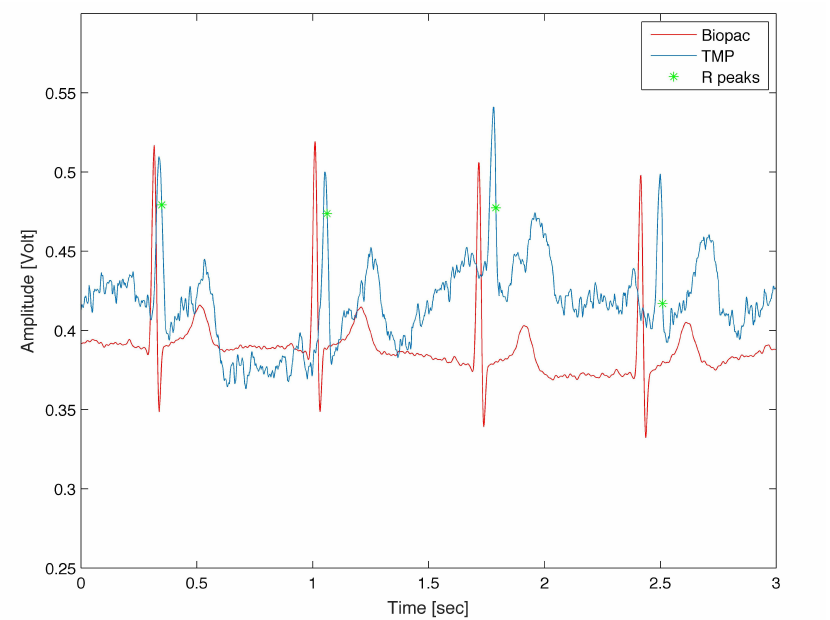
Figure 8. Synchronised ECG signals acquired from thorax region with Biopac instrument (red line) and from finger site with TMP system (blue line). TMP signal is processed with WFDB tool and R peaks detected are marked with green * symbols.